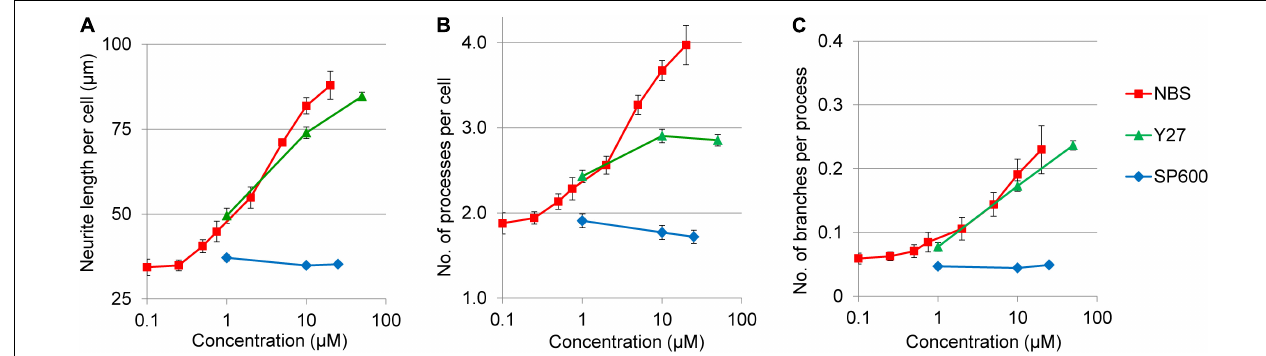
FIGURE 6 | Dose response curves for various morphological parameters of NPCs treated with ROCK1 and JNK inhibitors. The neurite length per cell (A) , the number of projections per cell (B) , as well as the neurite branching (C) was stimulated by Y27632 (Y27) in dose dependent manners, whereas SP600125 (SP600) had no such effects. The values were determined 3 h after treatment. The NBS stimulated dose response curves were used as references. The mean ± SEM from three independent experiments are